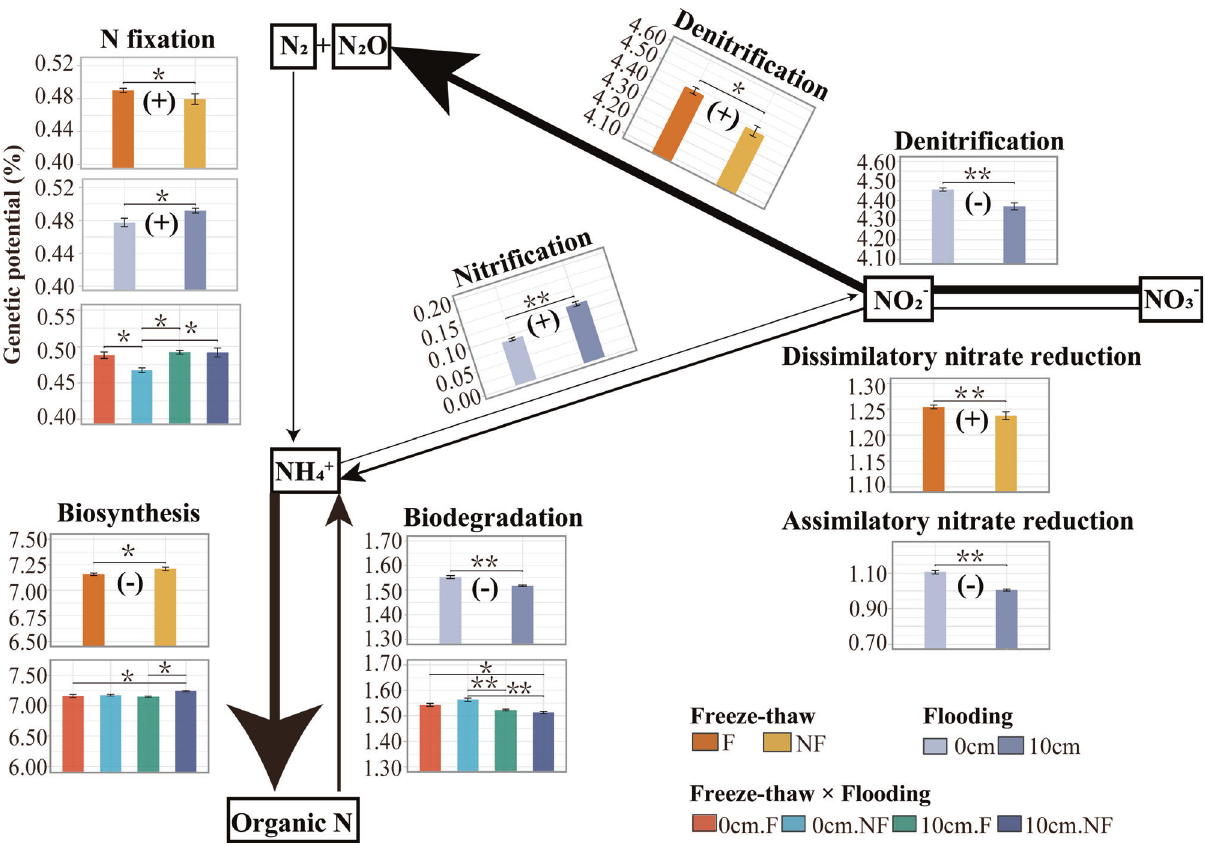
Fig. 3 Nitrogen cycle pathways in wetland soils with varied treatments. Arrow sizes are proportional to the genetic potential for metabolic processes. Bar plots are the genetic potential of N-cycling metabolic processes which were calculated using the relative abundance of N-cycling functional genes. “ + ” indicates that the genetic potential signi fi cantly increased under fl ooding or the carry-over effect of freeze-thaw, and “ − ” indicates a decrease. Metabolic processes with signi fi cant differences under fl ooding conditions and the carry-over effects of freeze-thaw are shown. ** p < 0.01; * p < 0.05; error bars denote SE (freeze-thaw: n = 6; fl ooding: n = 6; freeze-thaw × fl ooding: n = 3); 0 cm: non- fl ooding; 10 cm: fl ooding; F: freeze-thaw treatment; NF: control; 0 cm. F: non- fl ooding × freeze-thaw; 0 cm. NF: non- fl ooding × control; 10 cm. F: fl ooding × freeze-thaw; 10 cm. NF: fl ooding ×